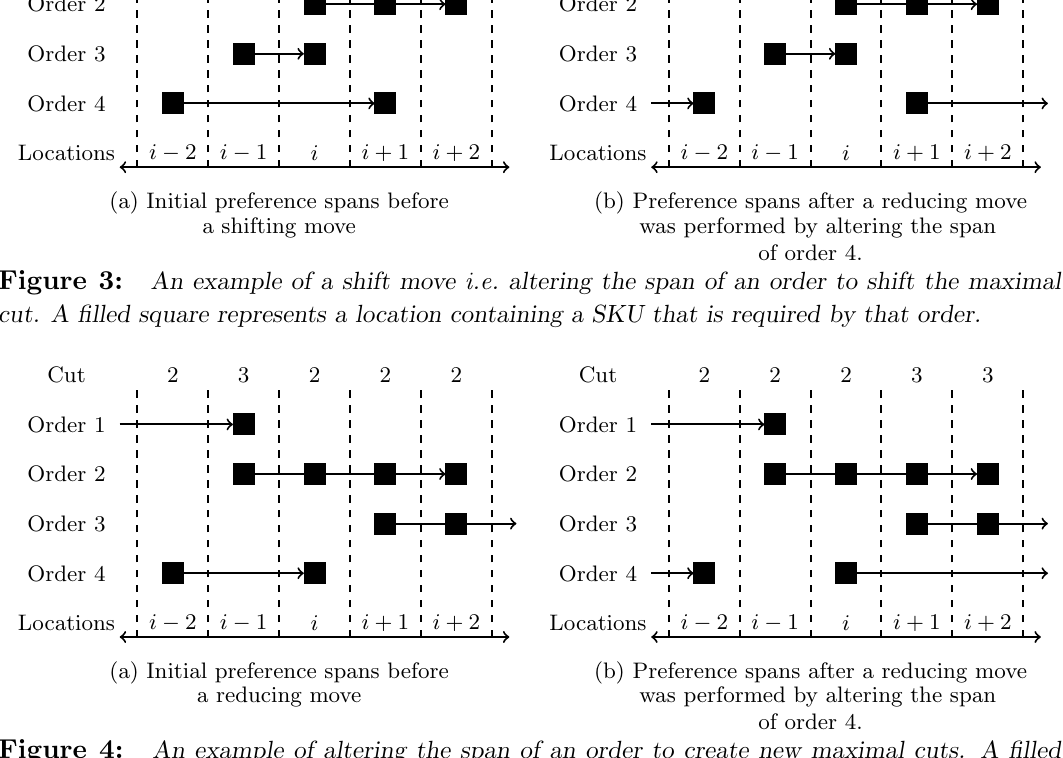
An example of altering the span of an order to create new maximal cuts. A filled square represents a location containing a SKU that is required by that